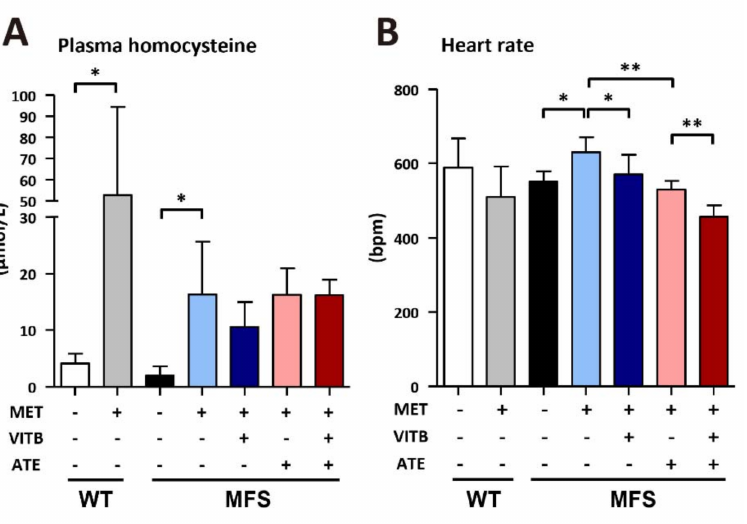
Figure 2. The effect of methionine and VITB treatment on plasma homocysteine and heart rate. ( A ) Plasma homocysteine in WT and MFS mice with different regiments ( n = 3–5 per group). ( B ) Heart rate counts were measured by tail-cuff in WT and MFS mice with different regiments ( n = 5–11 per group). Data are presented as the mean ± SD. * p < 0.05, ** p <